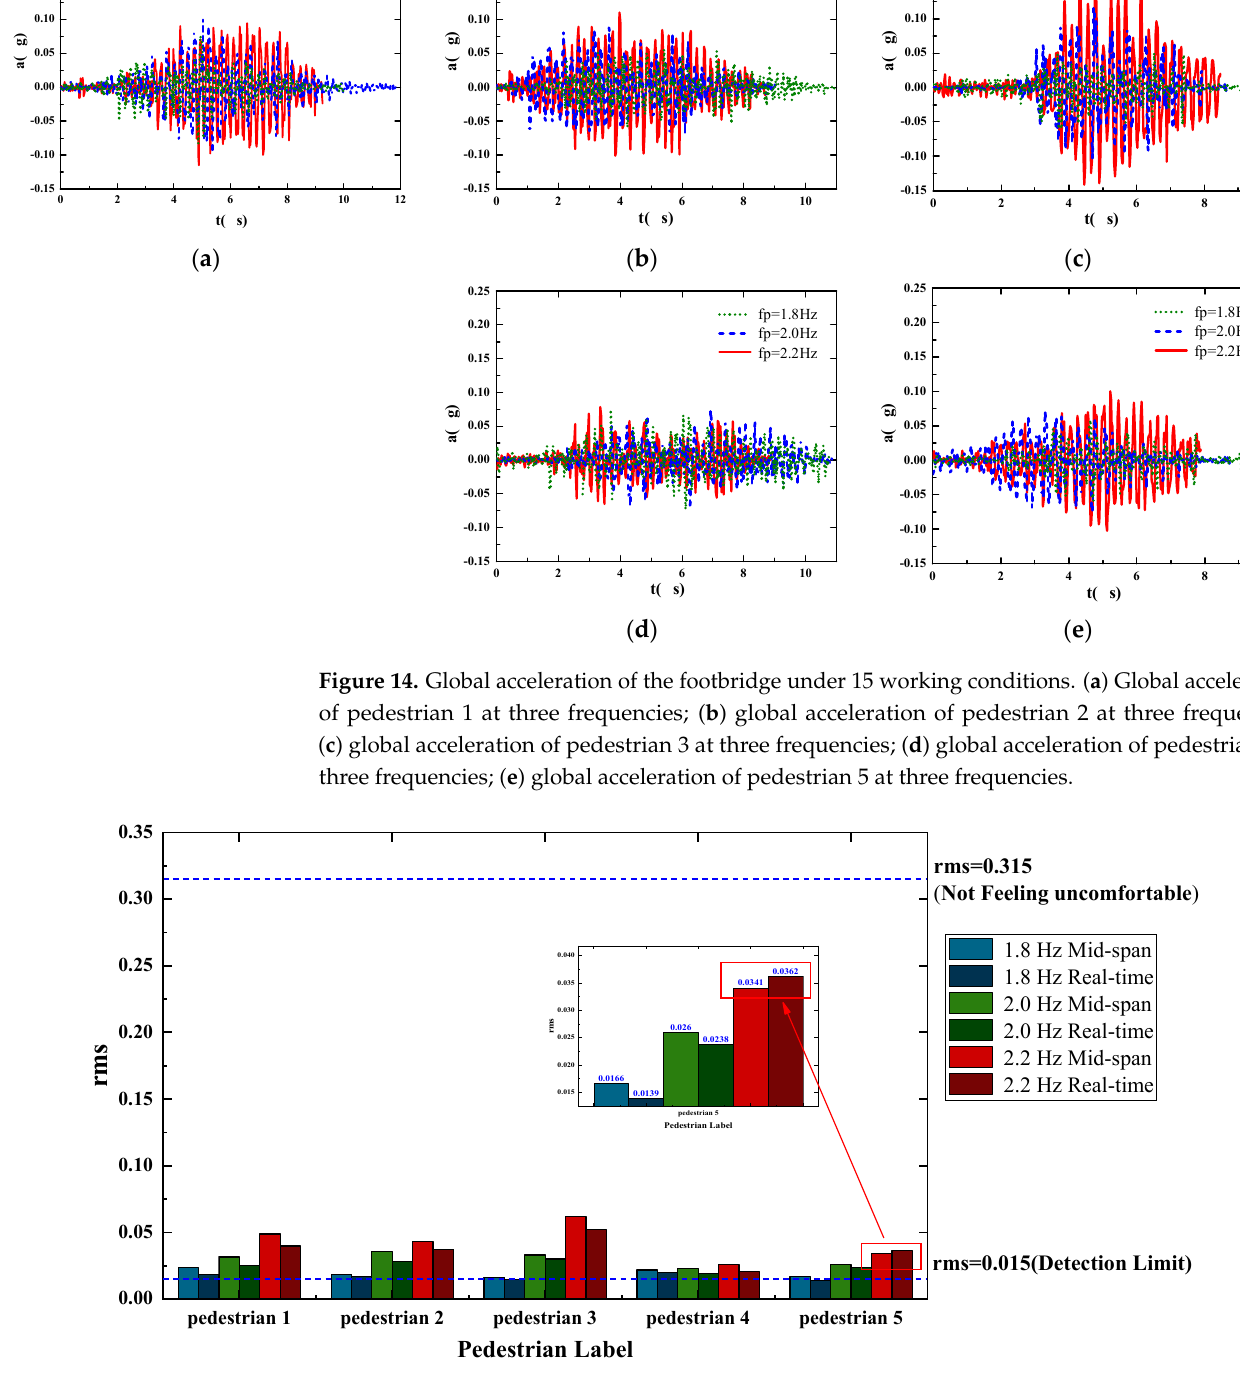
Figure 15. Global rms of the footbridge under 15 working